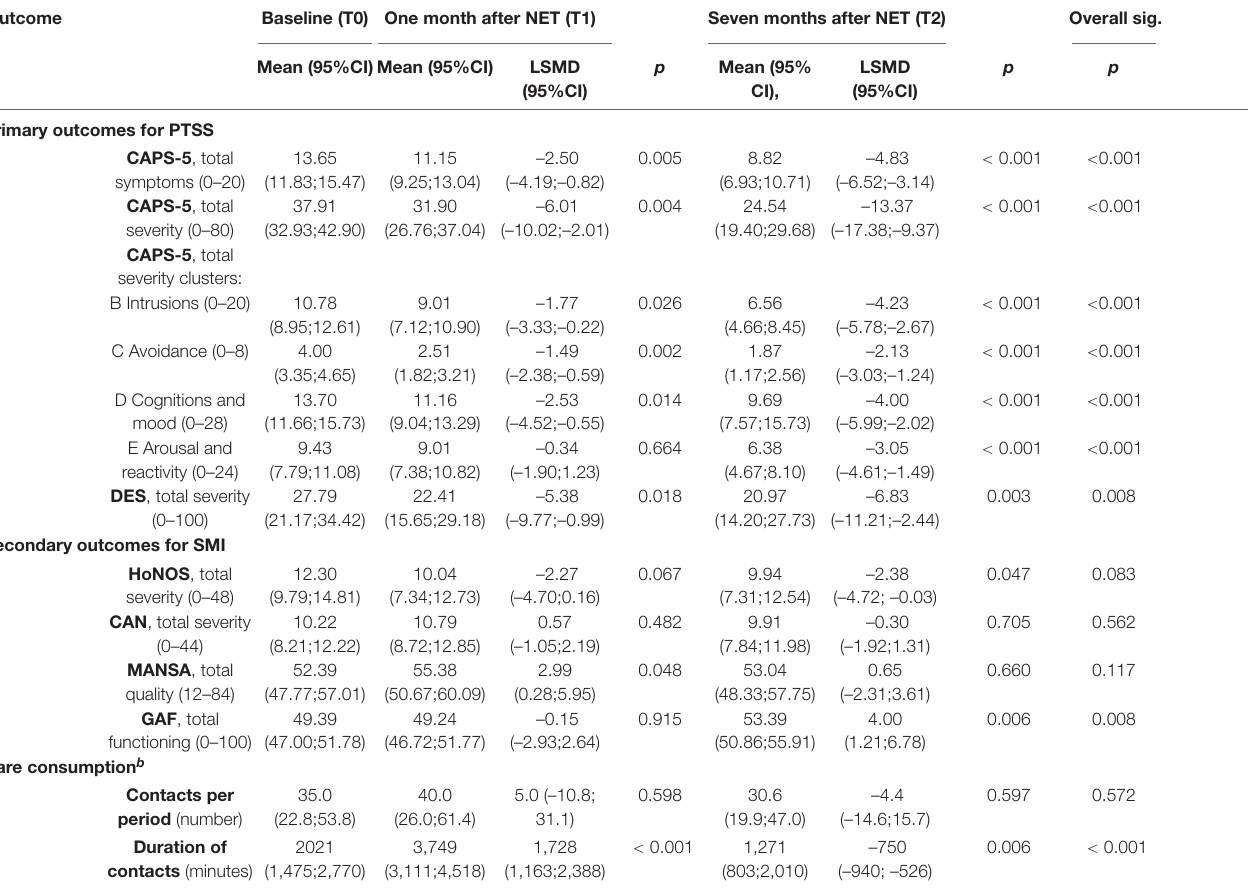
TABLE 2 | Results of primary and secondary outcomes based on a mixed model analysis for repeated measures (MMRM) of the full analysis set (FAS). a